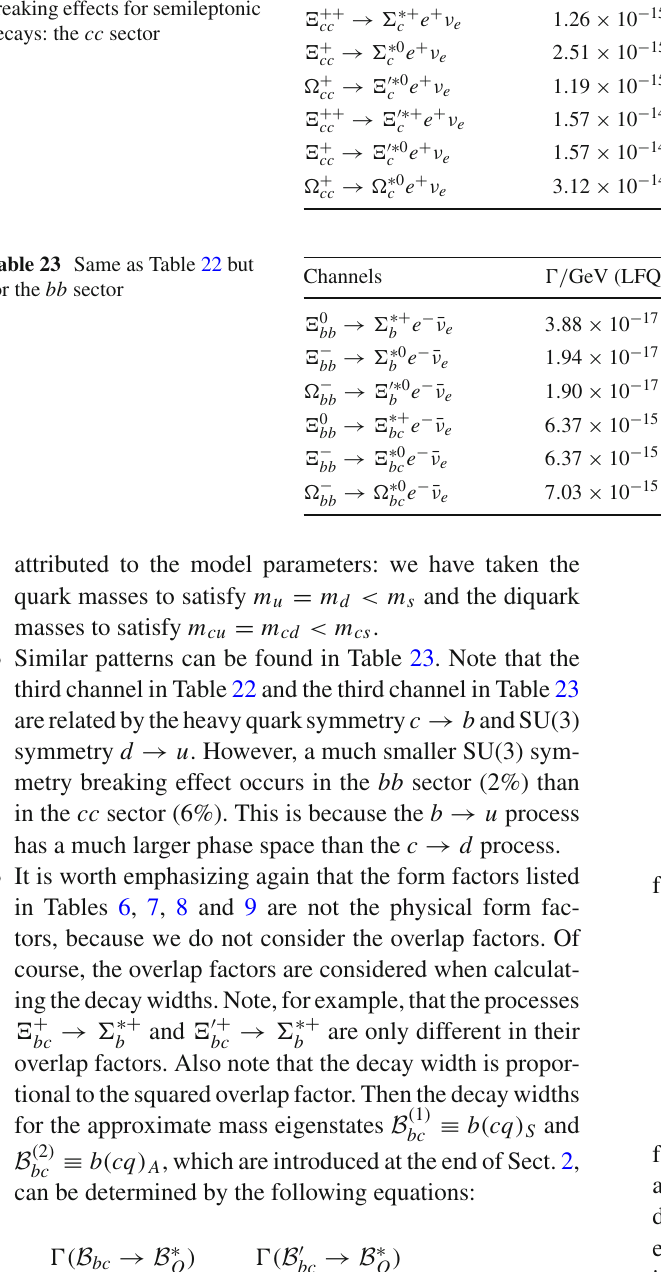
Table 22 Quantitative predictions of SU(3) symmetry breaking effects for semileptonic decays: the cc sector